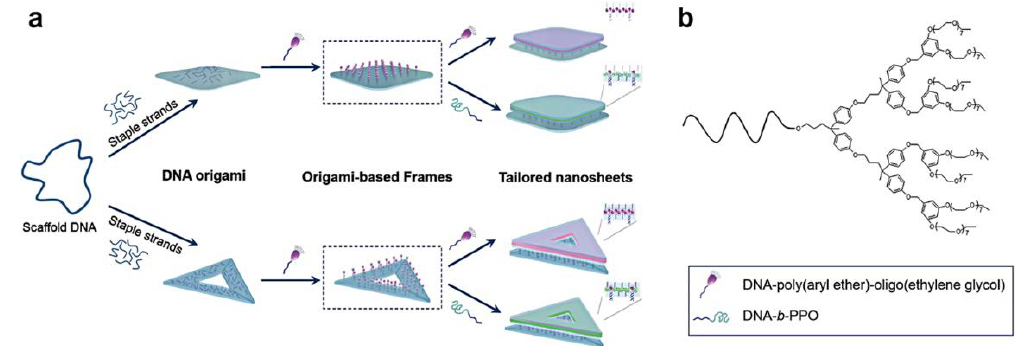
Figure 9. Illustration of the 2D nanosheets assembled from amphiphilic molecules on the DNA origami. ( a ) First, DDOEG molecules were anchored on the rectangular and triangular DNA origami structures by DNA hybridization, which leads to a high local concentration of hydrophobic molecules on the DNA origami surface. Subsequently, this surface works as a frame to guide the free hydrophobic molecules to assemble through hydrophobic effects, finally to generate continuous 2D nanosheets above the DNA origami. ( b ) The structure of DDOEG molecule. The purple molecule indicates DDOEG and the light green color indicates PPO segment. Reproduced with permission from the authors of a